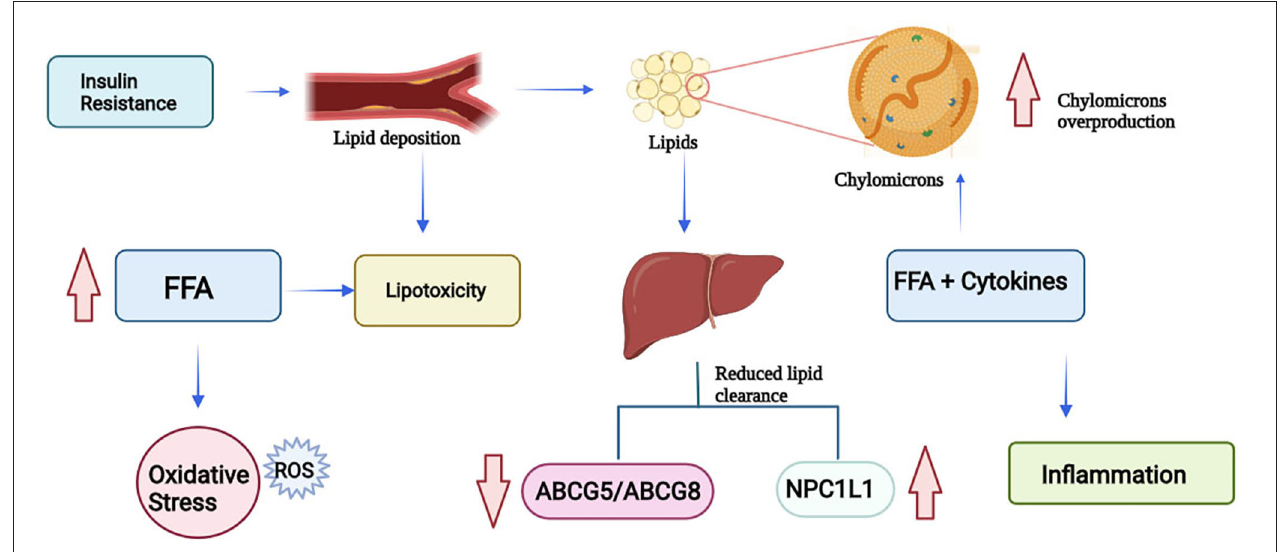
FIGURE 2 | Lipotoxicity process due to insulin resistance (FFA, Free Fatty Acids; ROS, Reactive Oxygen Species; NPC1L1, Niemann-Pick C1-Like 1; ABCG5, ATP-Binding Cassette Subfamily G Member 5; ABCG8, ATP-Binding Cassette Subfamily G Member 8) (Created in